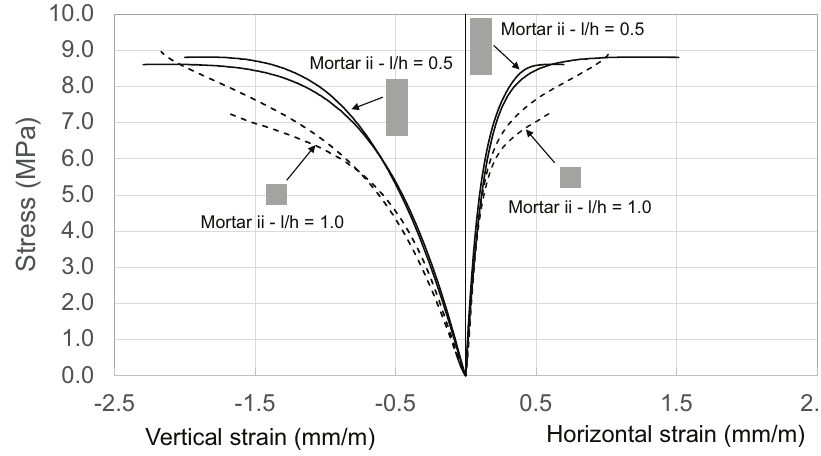
Figure 10 Vertical and horizontal deformations of prismatic